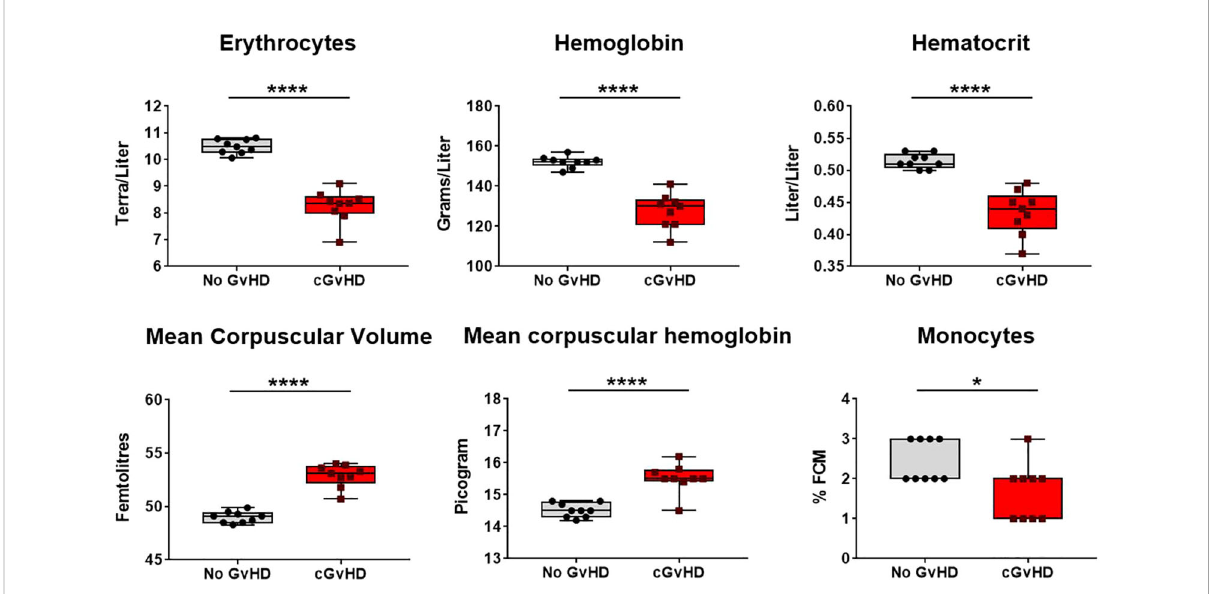
FIGURE 11 Recovery of red blood cells and related factors in cGvHD at d+90 after transplantation in C57BL/6 ➔ BDF1. Blood was sampled from mice and differential blood count was performed by Synlab, Berlin. Data pooled from 2 independent experiments. n=9. Error bars represent mean ± SEM.